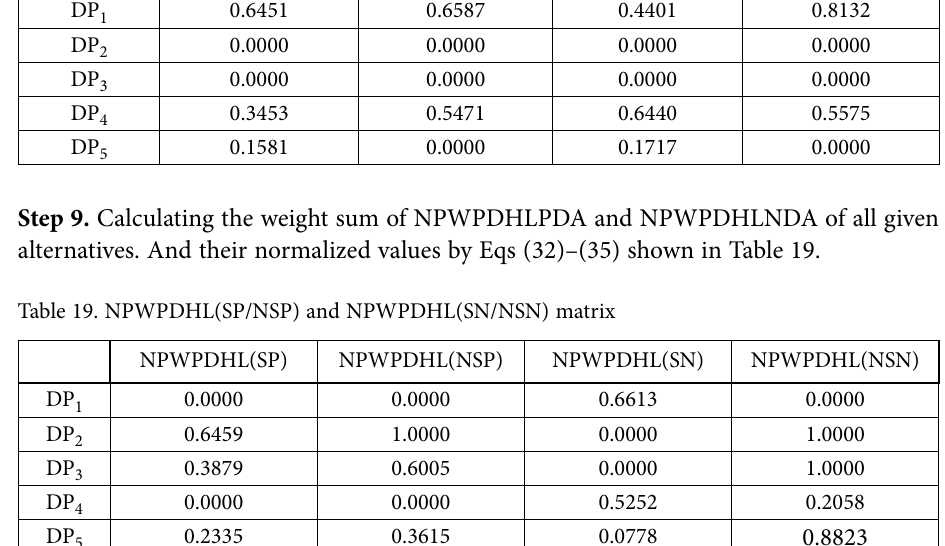
Table 18. NPWPDHLNDA matrix AT 1 AT 2 AT 3 AT 4